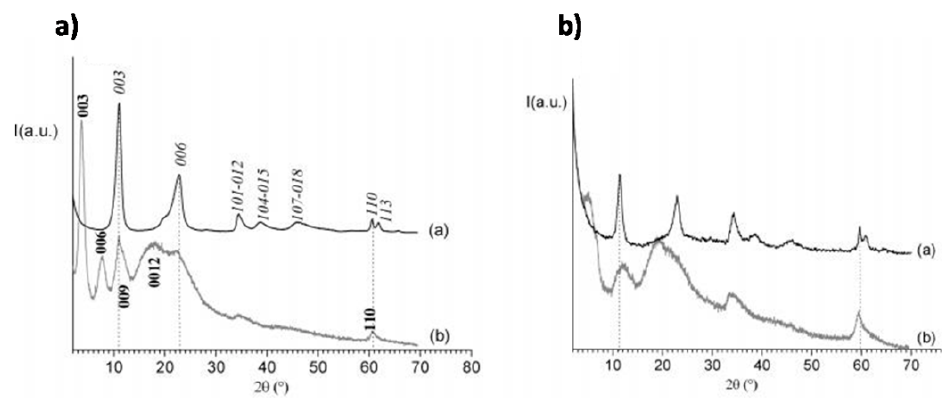
Figure 12. Powder X ‐ ray diffraction patterns in the 2 θ range 2°–70° of LDH/DNA Hybrids. ( a ) Mg 2 Al/NO 3 (spectrum a) and Mg 2 Al/DNA (spectrum b). ( b ) Mg 2 Fe/NO 3 (spectrum a)